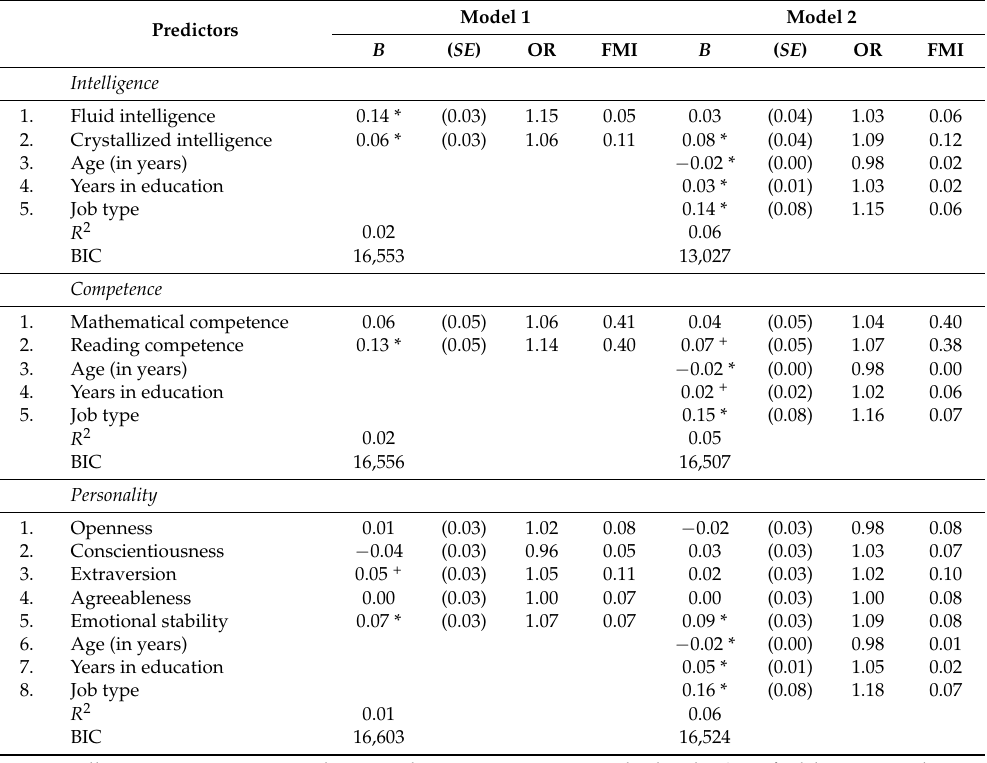
Table 2. Cox regression models for intelligence, competence, and